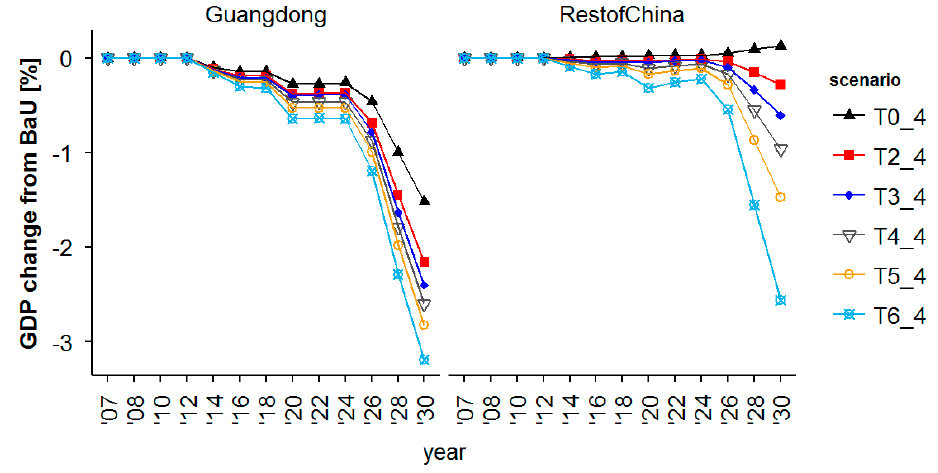
Figure 12. Impacts on GDP under di ff erent carbon tax policies compared with